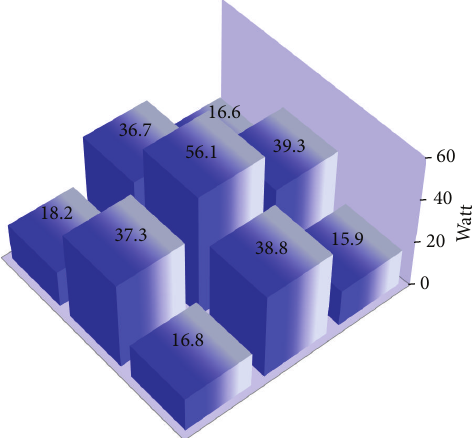
Figure 12: Distribution of power amplitudes (in watts) transmitted by CTPCs for a 300 W